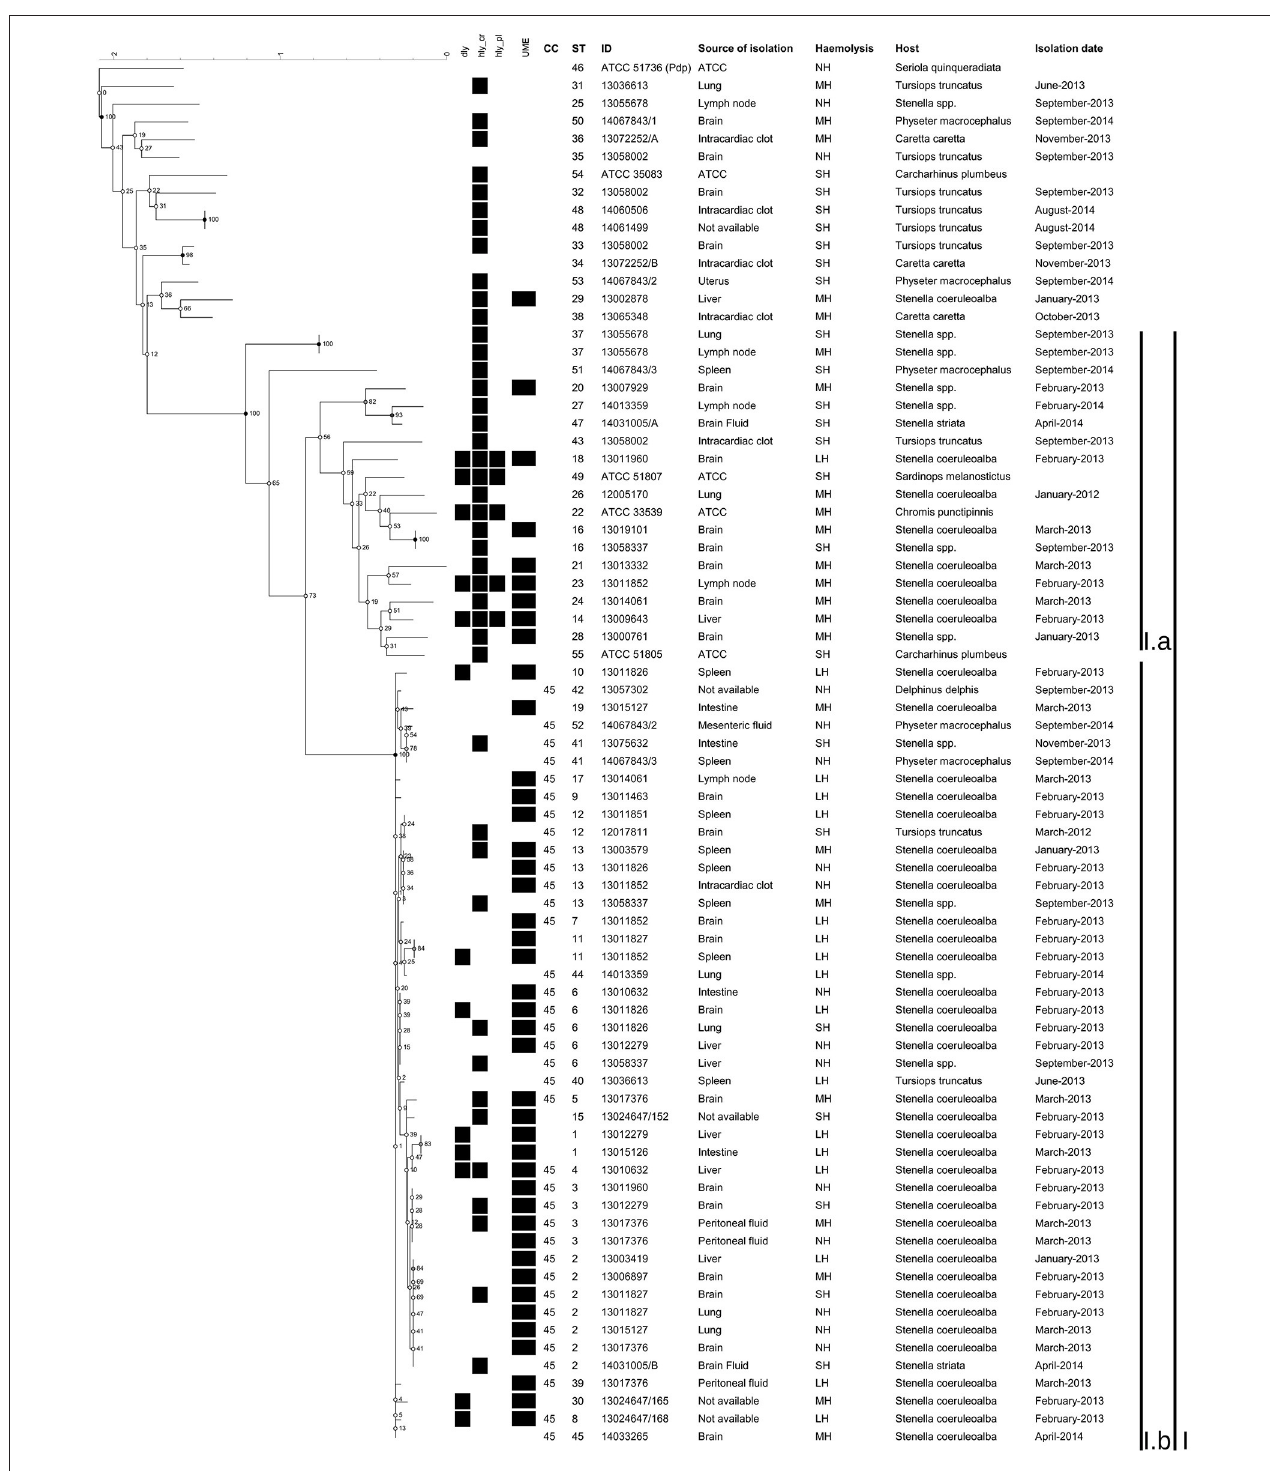
FIGURE 2 | Phylogenetic tree of the concatenated sequences built using Bionumerics. Phylogenetic tree constructed using Neighbor-joining method based on a multiple alignment. None position was discarded, having a total of 2739 bases in the final dataset. The tree topology was tested using 500 bootstrap. The haemolysin genes detected, the defined UME group, the CC, the ST, the haemolytic phenotype, the dates of isolation, the ID of the isolates, the sources of isolation and the hosts were included.